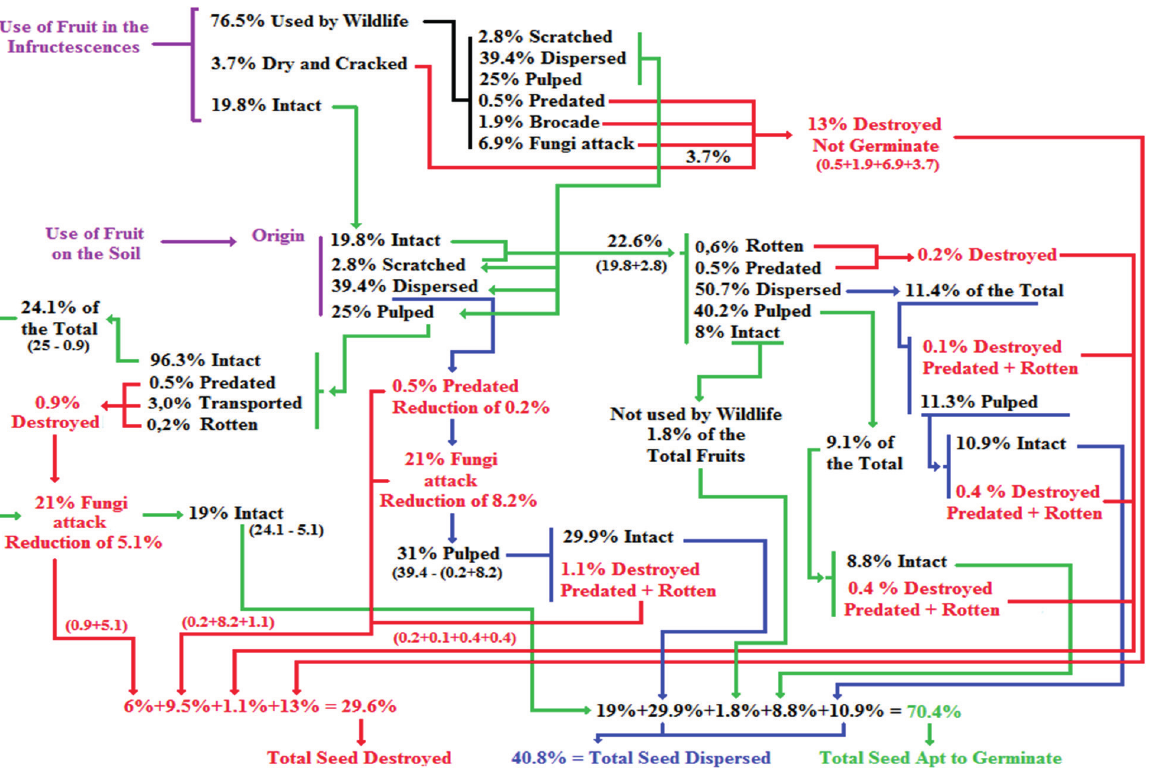
Figure 1 - A schematic overview of the wildlife and microorganismal activities that occurred during E . edulis fruiting (from 114 infructescences and 1,253 samples of unripe, ripe, dried, and pulped fruit placed on the ground, with 73,129 fruit per